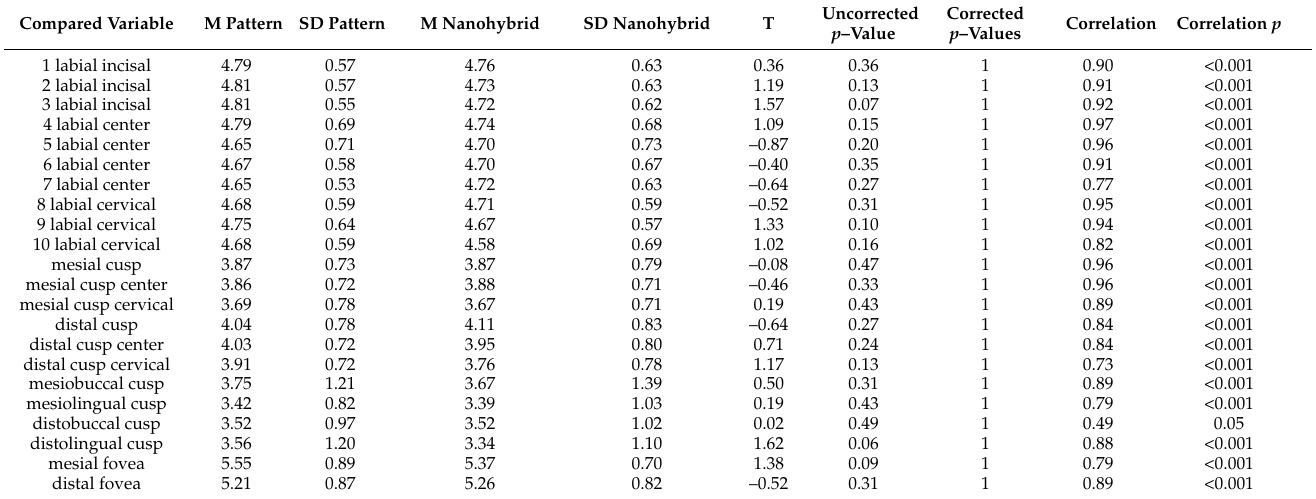
Table 2. Correlations between dimensions of mouthguard patterns and nanohybrid